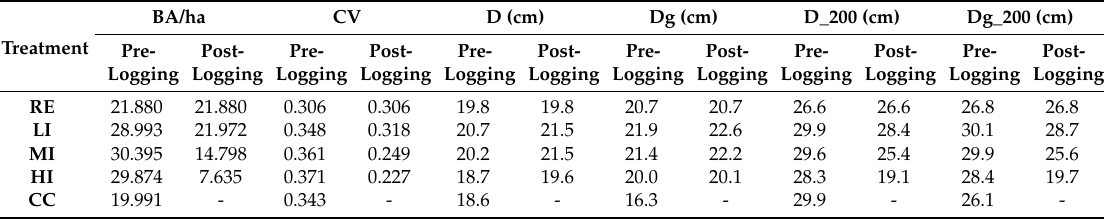
Table 2. Stand measures and index values of the plots before (pre-logging) and after the harvest operations (post-logging) in 1998. BA/ha=basal area (m 2 ) per hectare; CV: diameter coefficient of variation; D: arithmetic mean diameter of all measured trees; Dg: quadratic mean diameter of all measured trees: Dg_200: quadratic mean diameter of the 200 strongest trees per ha; D_200: arithmetic mean diameter of the 200 strongest trees per ha. RE = reference, no cutting; LI = low intensity; MI = medium intensity; HI = high intensity; CC = clear